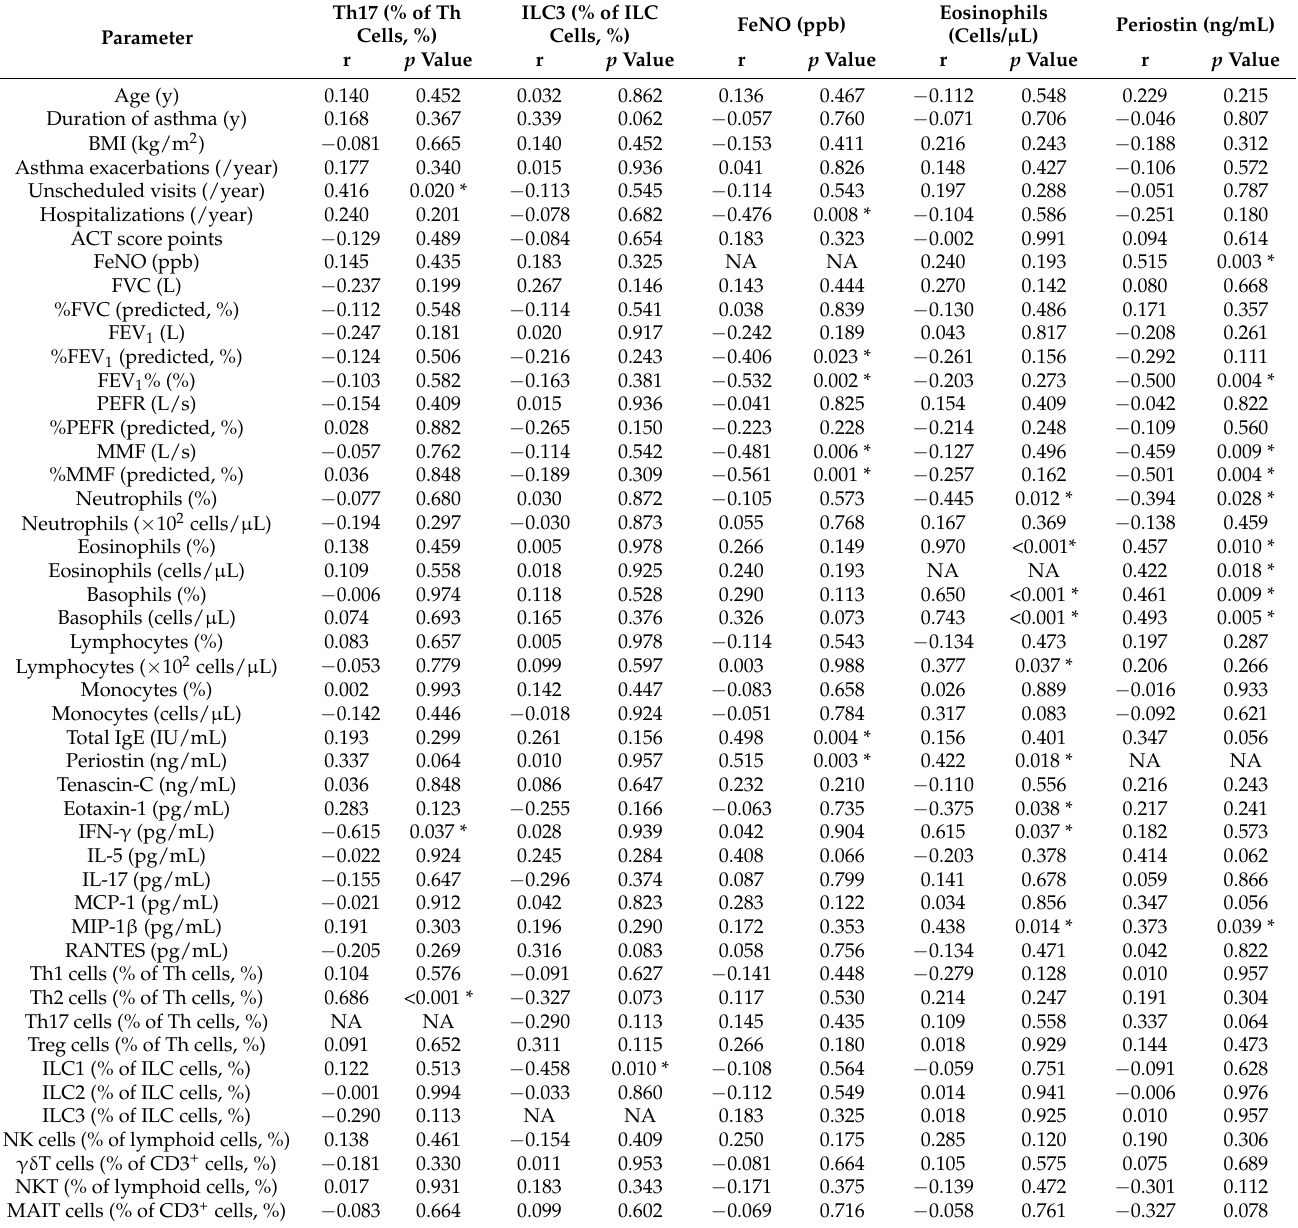
Table 5. The correlation coefficients between Th17, ILC3, FeNO, eosinophils, and serum periostin